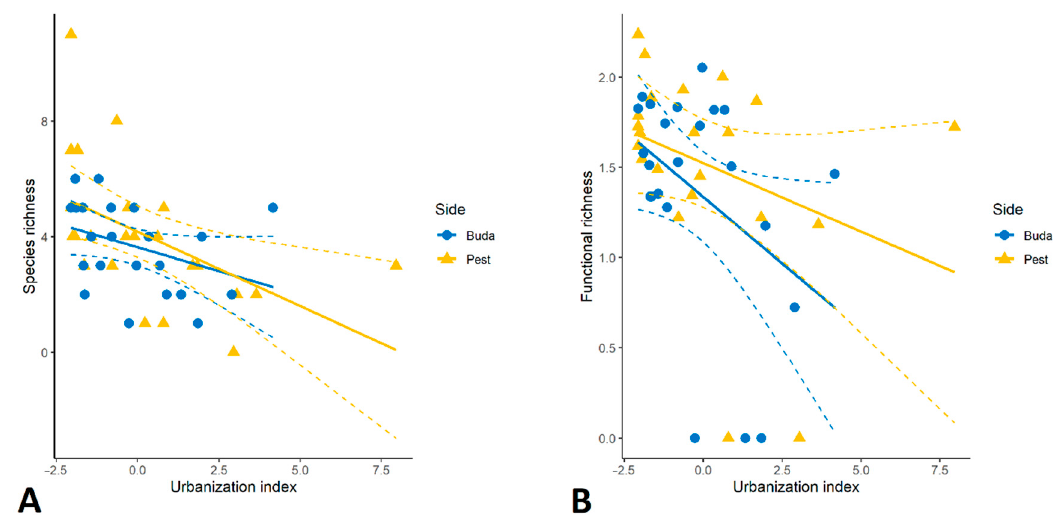
Figure 2. Relationship between species richness ( A ), functional richness ( B ) and urbanization on the two sides of Budapest. Dashed lines represent 95% confidence intervals.